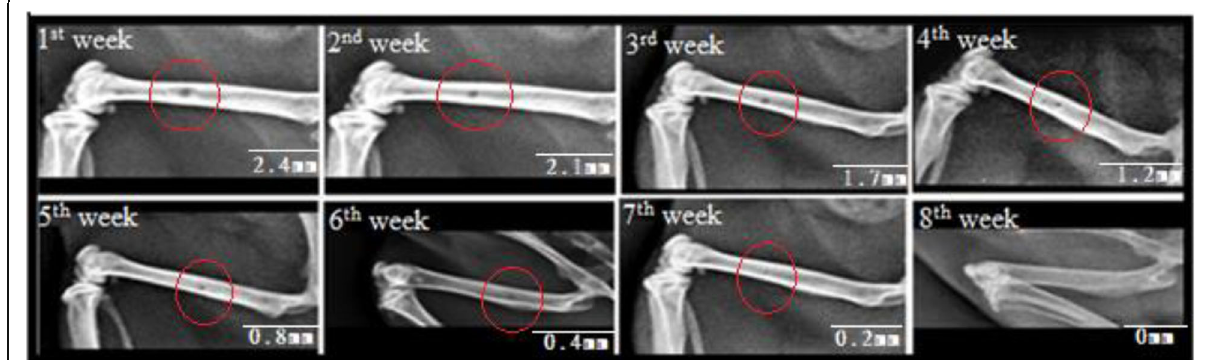
Fig. 4 Different images of a fractured bone in the group treated with a mixture of natural compounds during the period of 8 weeks